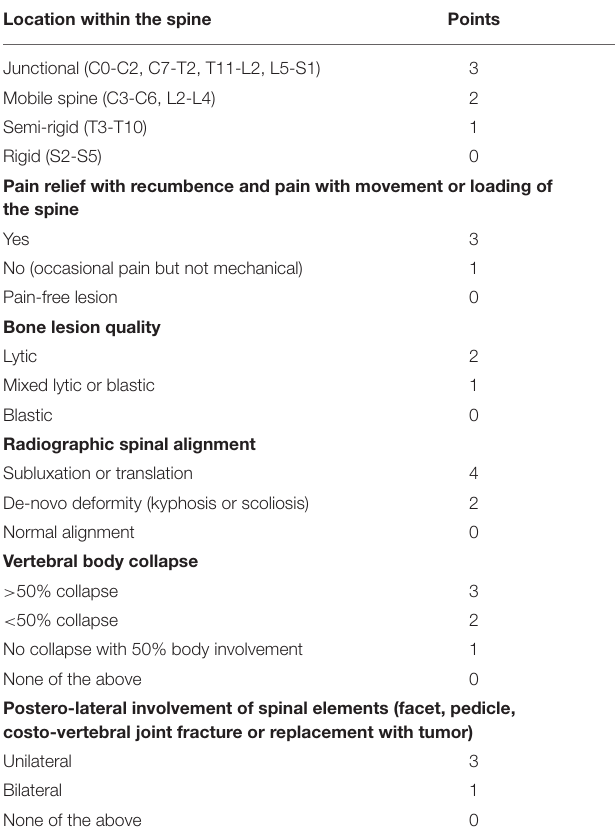
Frontiers in Oncology |